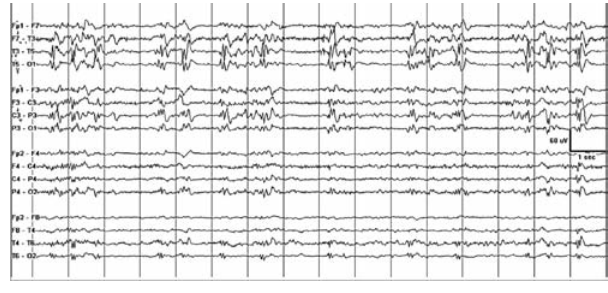
Figure 2. Electroencephalogram of Patient B showing left-sided burst suppression 30 minutes after clinical seizure termination with intravenous levetiracetam 1000 mg and propofol 2 mg/kg load. Fragments of burst activity spilling over the right hemi- sphere are most likely due to volume conduction from the left hemisphere source. Unihemispheric burst suppression was pres- ent during propofol infusion at 2 mg/kg/hr. It disappeared 2 hours later when the propofol infusion rate was 5 mg/kg/hr. Propofol was discontinued after 18 hours with no recurrence of seizure and unihemispheric burst